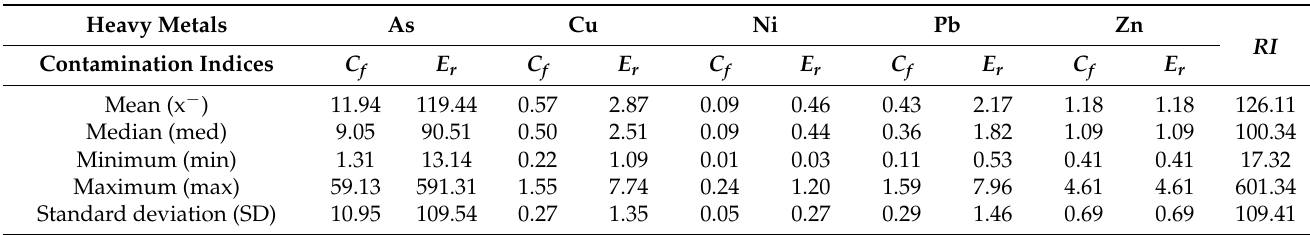
Table 6. Contamination factor ( C f ), Ecological risk factor ( E r ), and Potential Ecological Risk Index ( RI ) assessment of the toxic metals in the study soils.